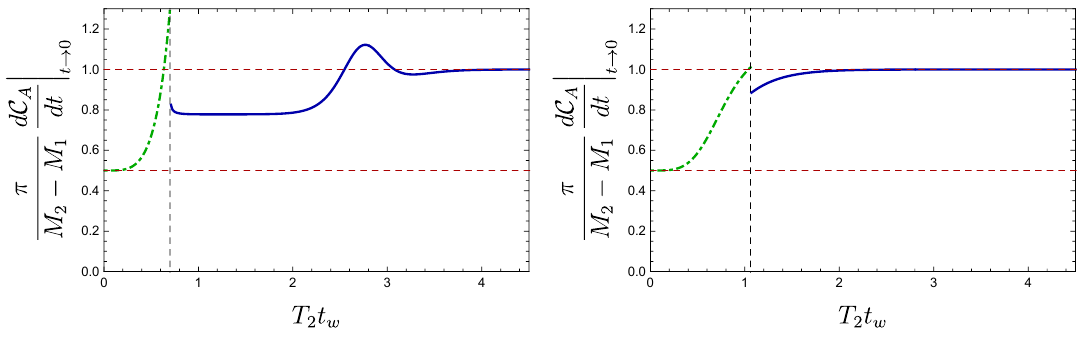
Figure 28. The growth rate of the holographic complexity at t = 0 for an AdS hole as a function of the perturbation time t w . We choose z = 1 =w (as de(cid:12)ned in eq. (2.18)) so that the smaller black hole is at the HP transition. The left and right panels show the results for w = 1+10 (cid:0) 6 and w = 2, respectively. The vertical dashed line indicates the transition from regimes ( a ) and ( b ) in eqs. (B.7) and (B.8). The rate of change starts at half of ( M 2 red line), as expected from the expansion in eq. (B.9), and for large t w the rate of ( M 2 (indicated by the upper dashed red horizontal line) is